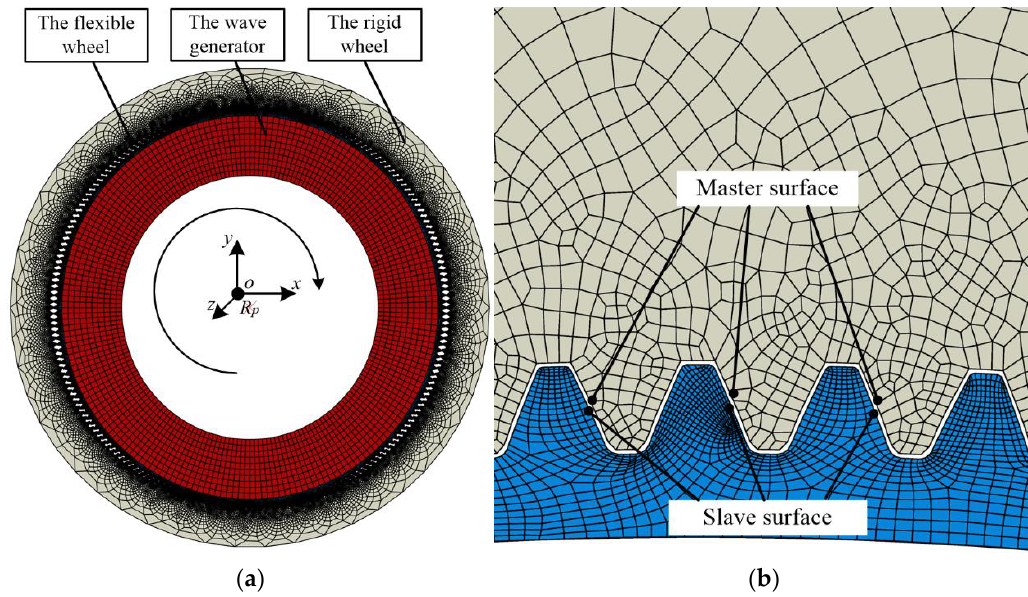
Figure 18. ( a ) Finite element assembly model of the disposable HD; ( b ) partial enlargement of the meshing region between the two gears.